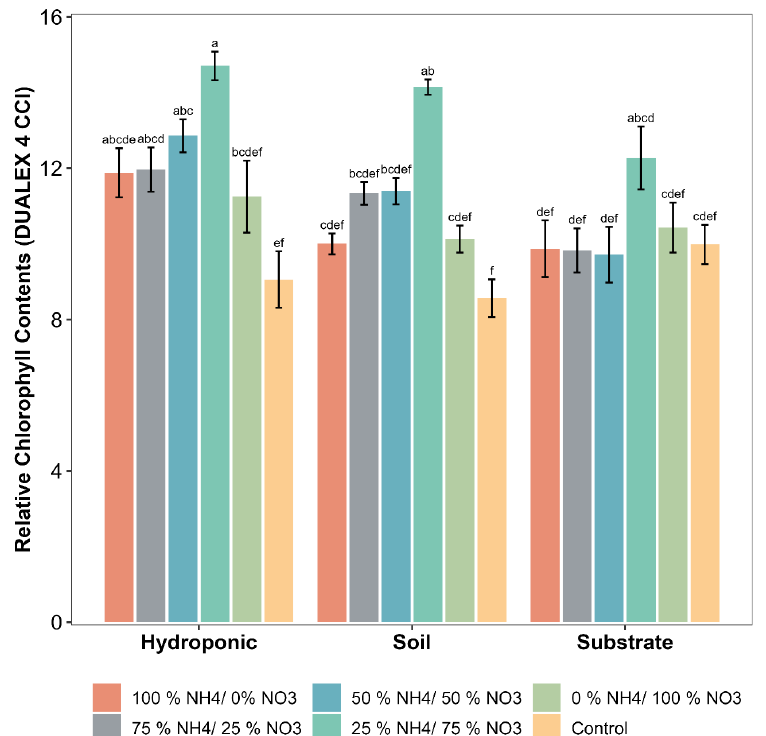
Figure 1. Effect of various applied NH 4 + /NO 3 − ratios on the relative chlorophyll contents of lettuce grown in soil, substrate and hydroponic cultivation systems. Note- The means ( n = 4) ± standard errors are shown in the data. Different letters (a–f) show significant difference ( p = 0.01) among